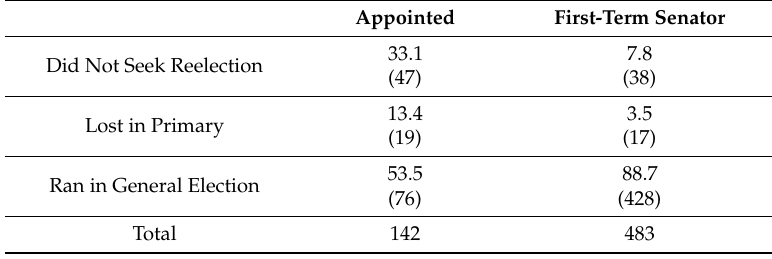
Table 1. The Decision to Seek Reelection for Appointed and First-Term